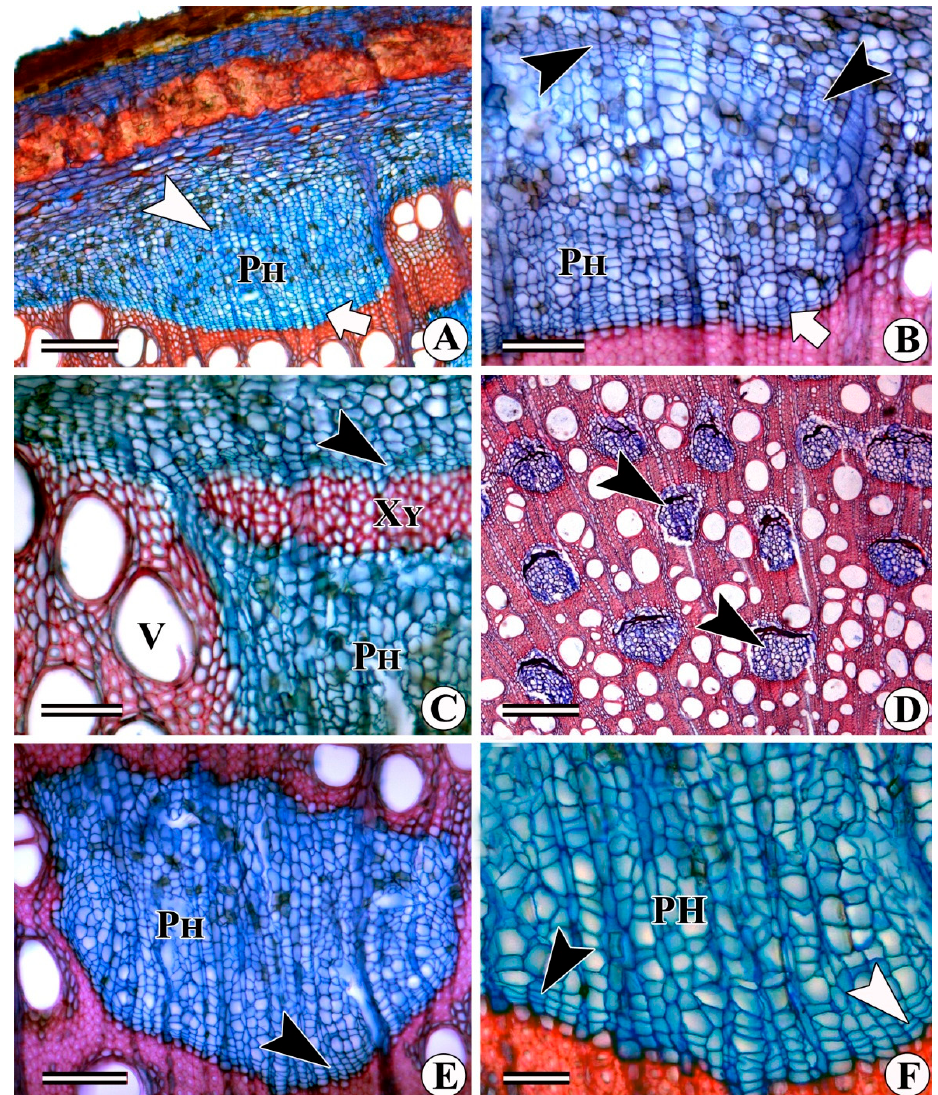
Figure 3. Transverse view of secondary xylem of Strychnos bredemeyeri ( A – C ), S. bicolor ( E ), and Salvadora oleoides ( F ) showing interxylary phloem strands. ( A ) Development of interxylary phloem island. Cessation of cambial cell division and formation of depression (arrow) followed by the development of a new cambial segment (arrowhead). Arrow indicates cambium in the depression. ( B ) Enlarged view of developing interxylary phloem island. Note the shallow depression and cambium (arrow). Arrowheads show a newly initiating cambial segment. ( C ) Initiation of deposition of lignified xylem derivatives (XY) by the cambium (arrowhead). ( D ) Interxylary phloem strands (arrowheads) embedded in the secondary xylem. ( E ) One of the interxylary phloem islands (PH) embedded within the secondary xylem. Note the cambium (arrowhead) on the inner margin of the phloem strand. ( F ) Enlarged view of Figure 3E showing radially arranged cambial cells (arrowheads) in one of the phloem islands. Abbreviations : PH = phloem embedded within the secondary xylem, V = vessel, XY = xylem. Scale bars: A, D = 200 µm; B, C, E = 100 µm, F = 50 µm.